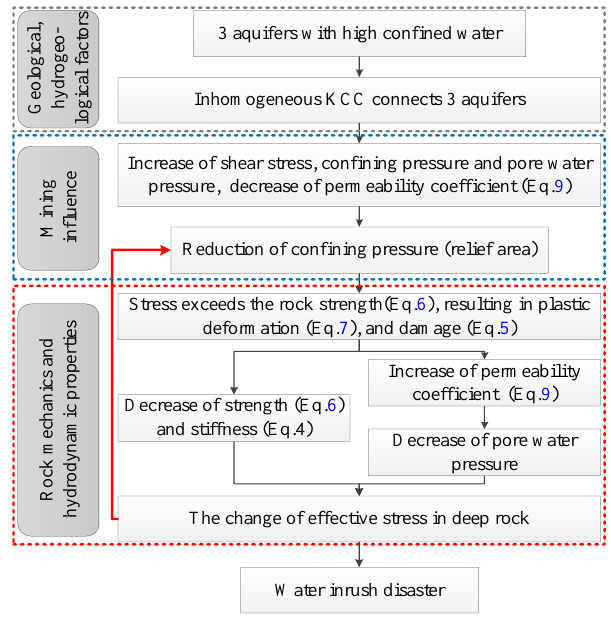
Figure 13. The process of cascade and vicious cycle for water inrush from KCC.